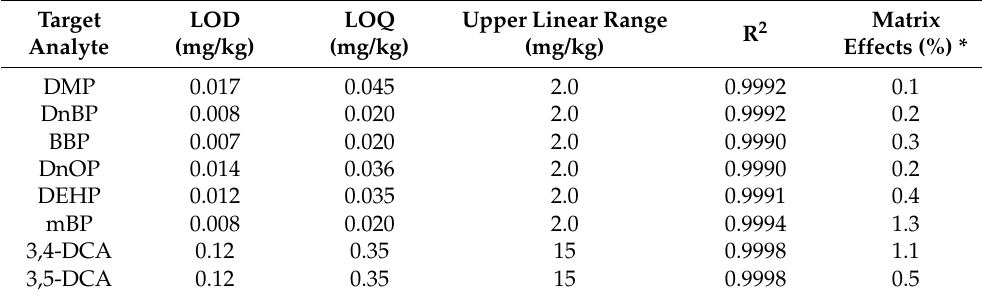
Figure 3. TIC chromatogram and MRM chromatograms in spiked rice samples (1.0 mg/kg for all target analytes), after QuEChERS cleanup. Table 2. Limits of detection (LODs), limits of quantification (LOQs), linear ranges, and linear regression coefficients for target